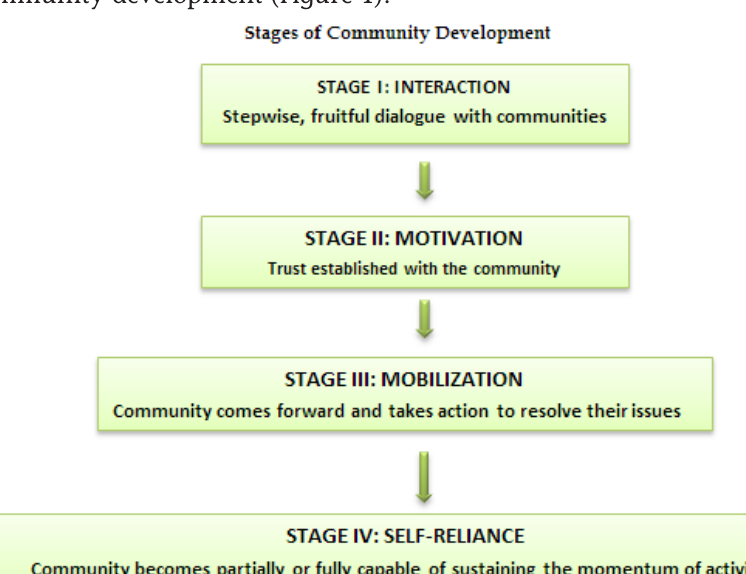
Figure 1: Adapted from